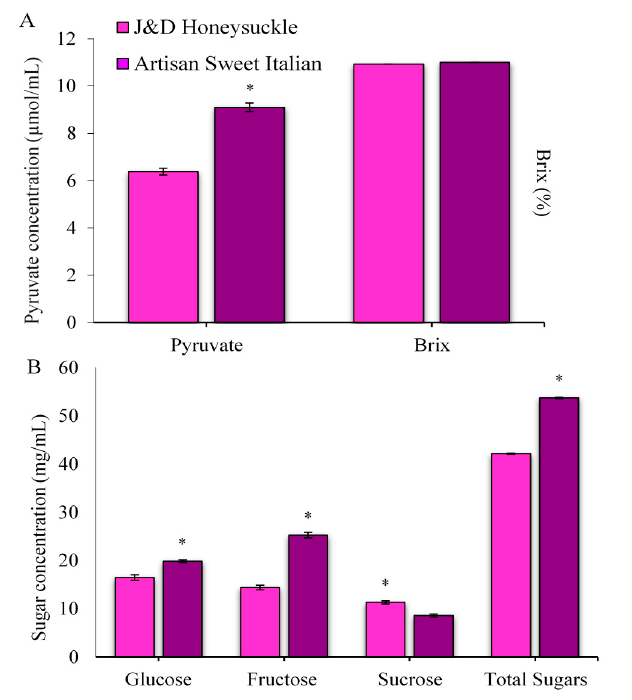
Figure 1. Onion varieties ( A ) honeysuckle and ( B ) sweet Italian.